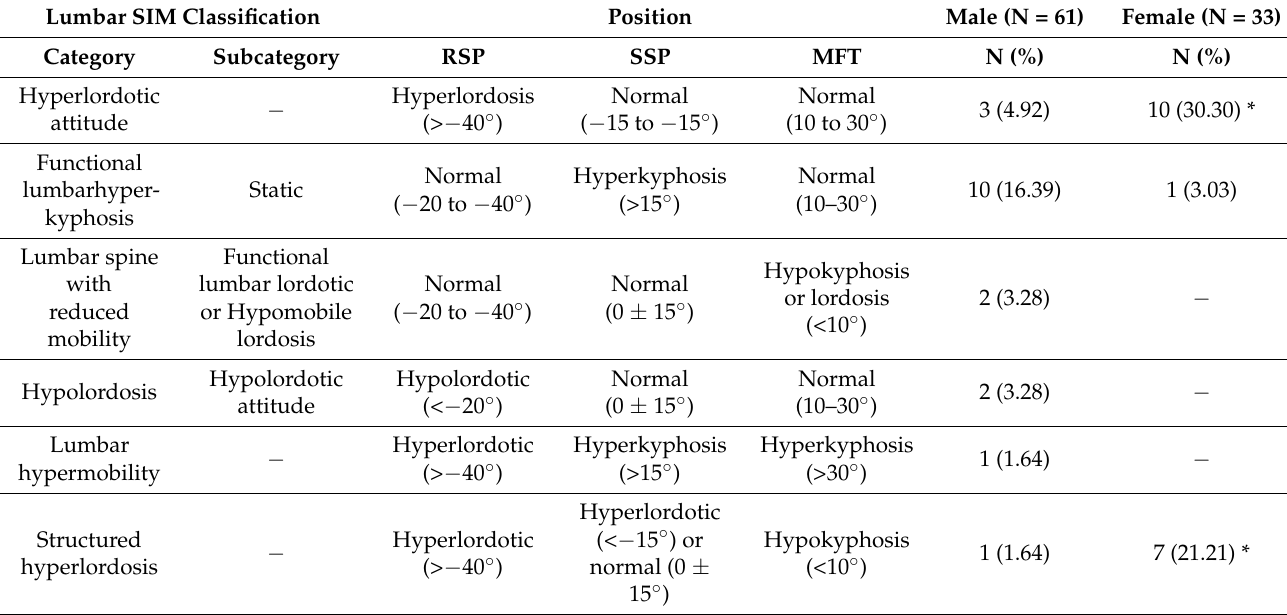
Table 4. Absolute and relative frequencies of SIM (sagittal integral morphotype) misalignments for lumbar curvature in competitive amateur athletes.